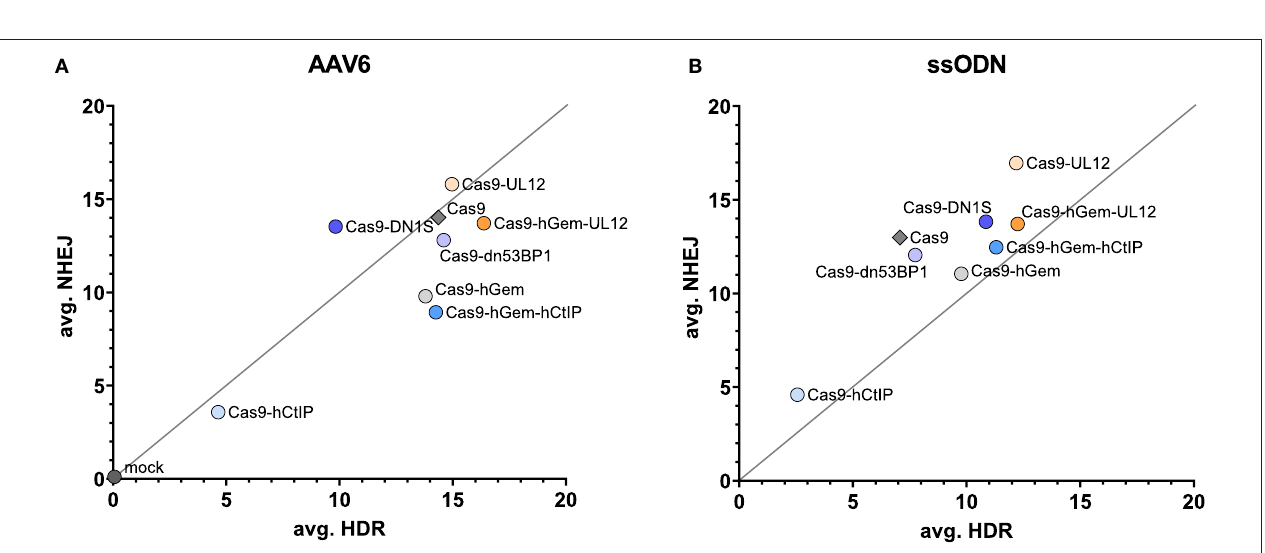
FIGURE 8 | Comparison of averageCas9 variant editing in HSPCs with a ssODN or AAV6 donor. (A) Average HDR vs. average NHEJ for all Cas9 variants assessed in this study. The y axis reflects average NHEJ editing, and the x axis reflects the average HDR editing of each variant at the HBB locus. Average editing of Cas9 variants targeting the SCD mutation in CD34 + HSPCs with an AAV6 donor (A) or an ssODN donor (B)